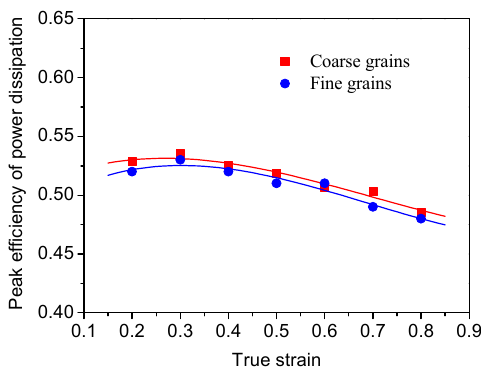
Figure 10. Variation in the efficiency of power dissipation with true strain at 950 °C/10 − 3 s − 1 for the TB8 titanium alloy with coarse-grained sizes and 900 °C/10 − 3 s − 1 for the TB8 titanium alloy with fine-grained sizes.